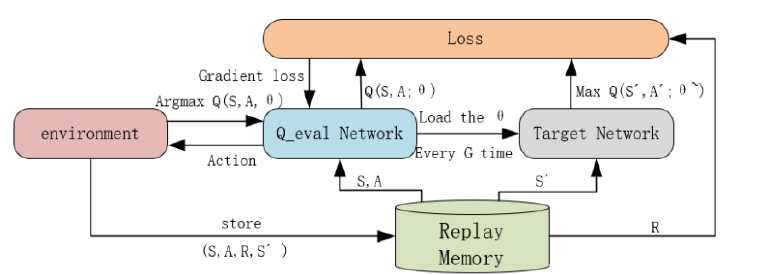
Figure 7. The structure of